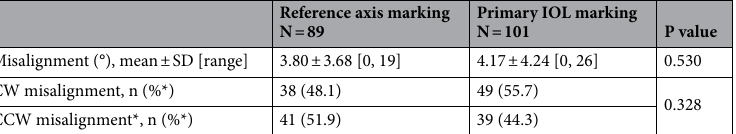
Table 5. Influence of the marking technique on the TIOL deviation and its direction. No correlation was found between TIOL deviation and axial length (r = 0.062, P = 0.397), anterior chamber depth (r = 0.055, P = 0.453), preoperative astigmatism (r = 0.026, P = 0.719), TIOL cylinder power (r = − 0.054, P = 0.455) and TIOL spherical power (r = − 0.028, P = 0.700). TIOL toric intraocular lens, CW clockwise, CCW counterclockwise. *IOLs that were precisely on the planned axis were excluded.